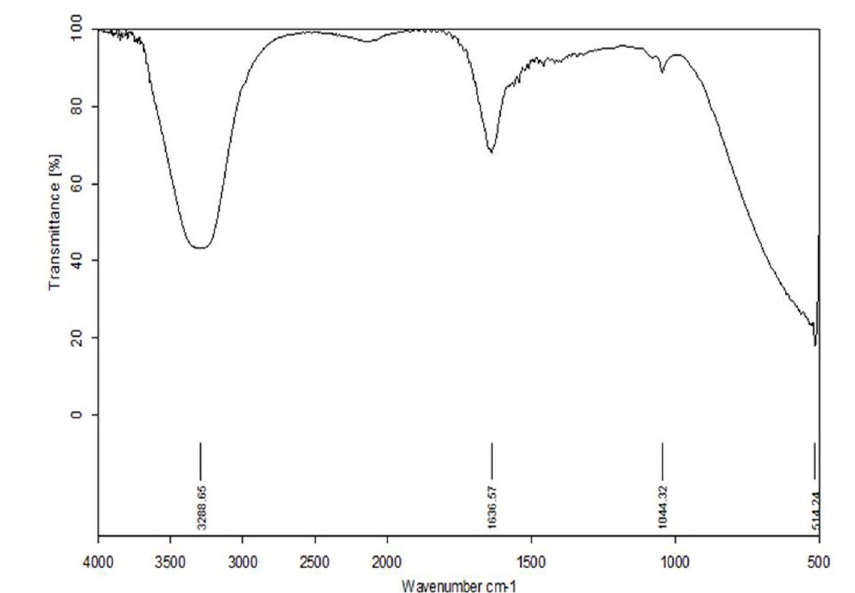
FIGURE 5 - : FTIR spectra of the ethosomal gel